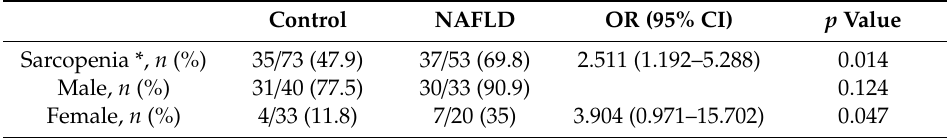
Table 2. Prevalence of sarcopenia in the control and NAFLD group.